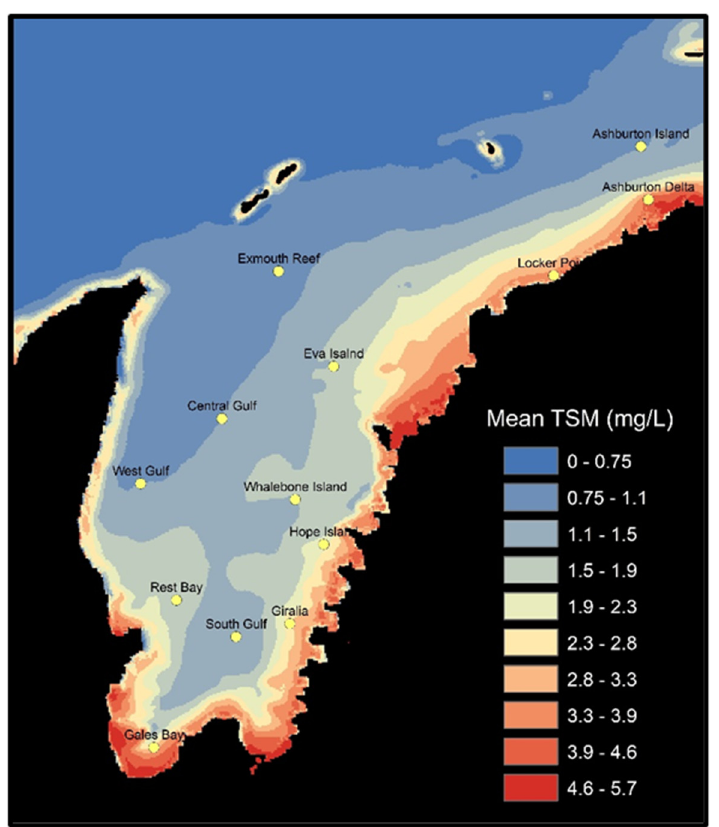
Figure 2. Mean monthly turbidity (TSM) in the Exmouth Gulf region over the period 2002–2020, retrieved from MODIS-aqua remotely sensed data with a locally calibrated turbidity algorithm applied.